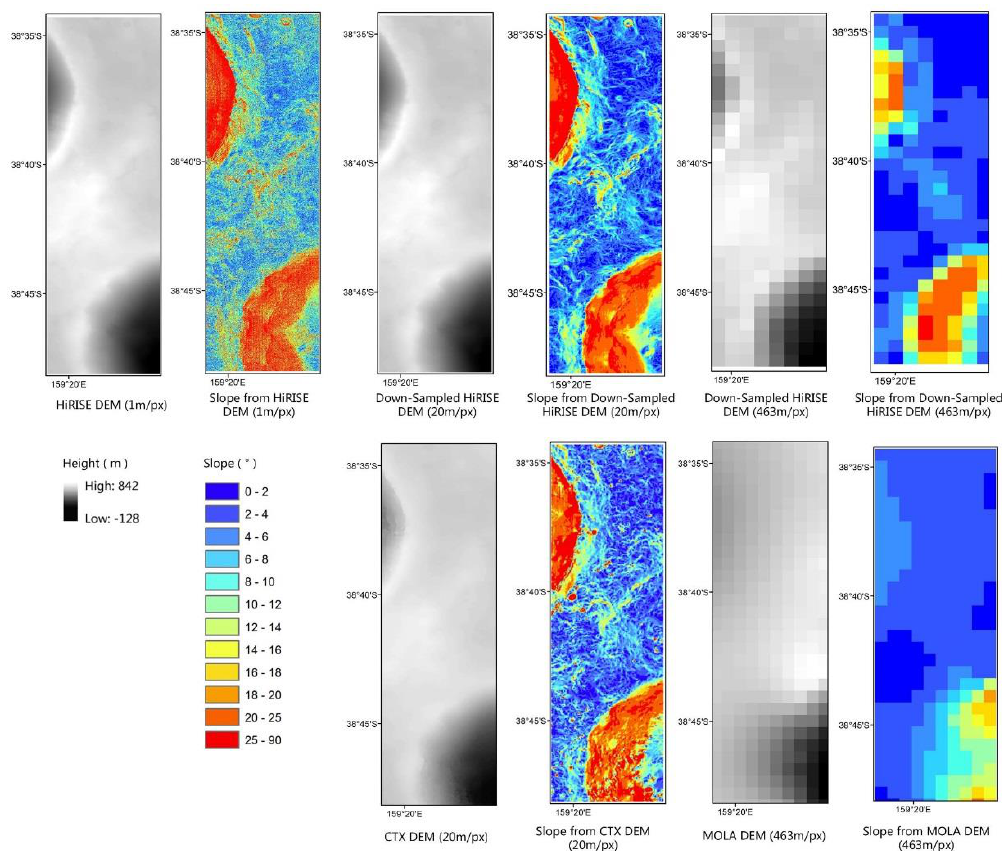
Figure 2. Example of slope smoothness when the resolution of DEM decreases.